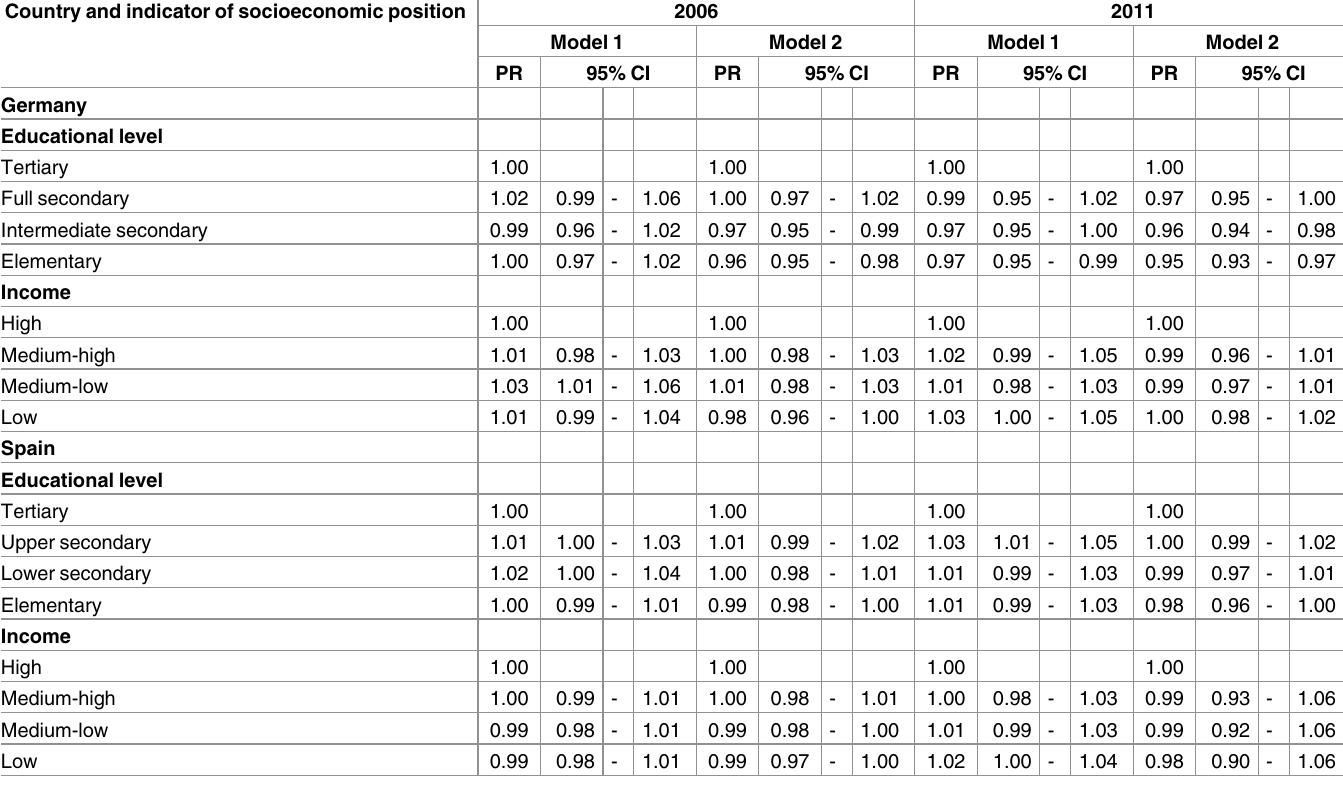
Table 3. Physician consultation by educational level and income. Percentage ratio (PR) and 95% confidenceinterval(95% CI). Country and indicator of socioeconomic